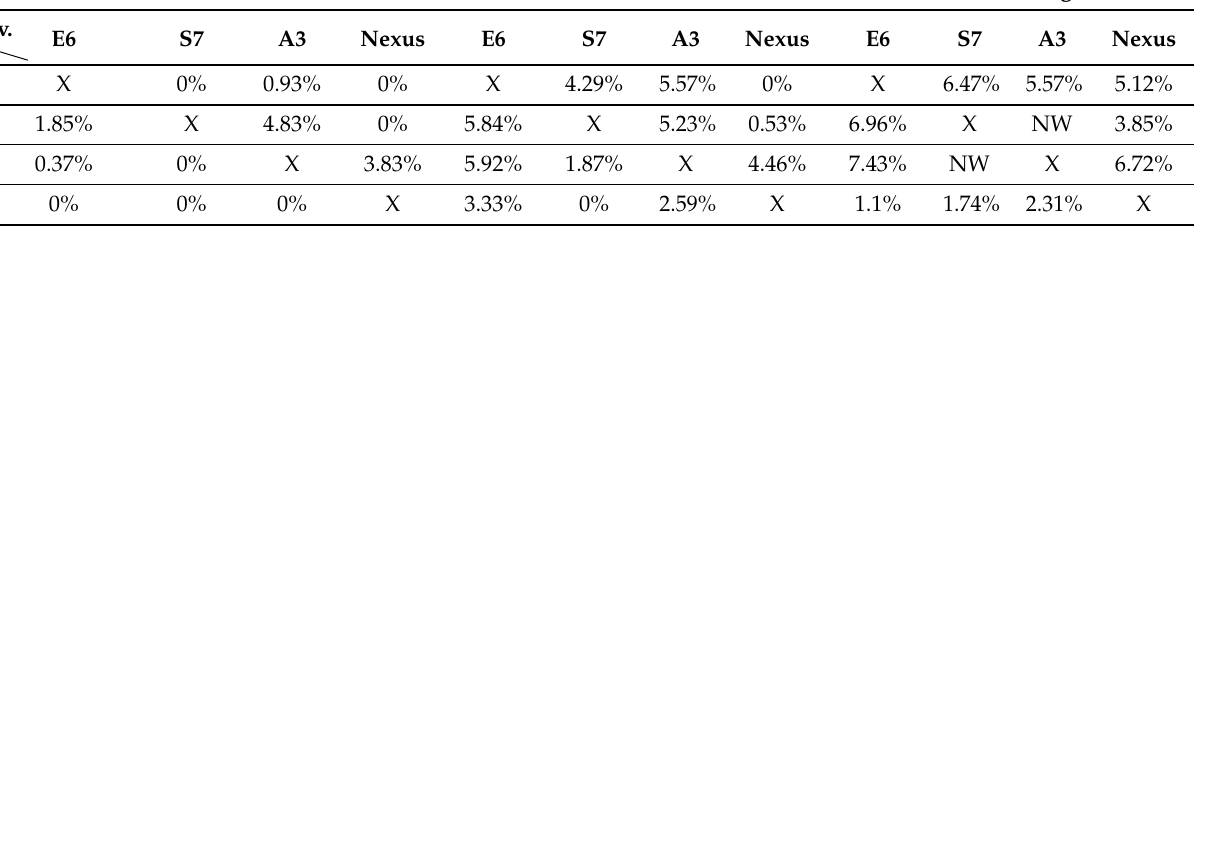
Front Left-Right